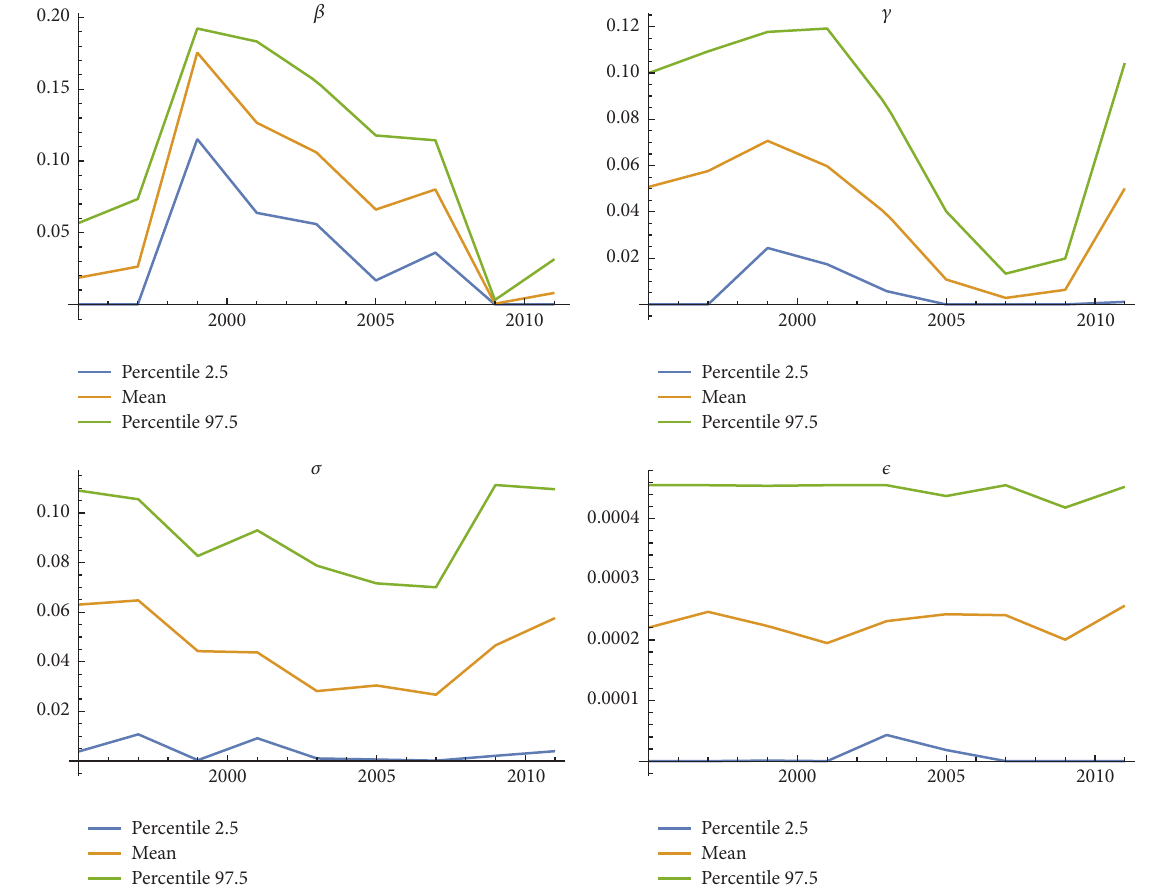
Figure 4: Estimated 95 % confidence intervals (band) and means of the random processes 𝛽 𝑡 , 𝛾 𝑡 , 𝜎 𝑡 , and 𝜖 𝑡 plotted in Figure